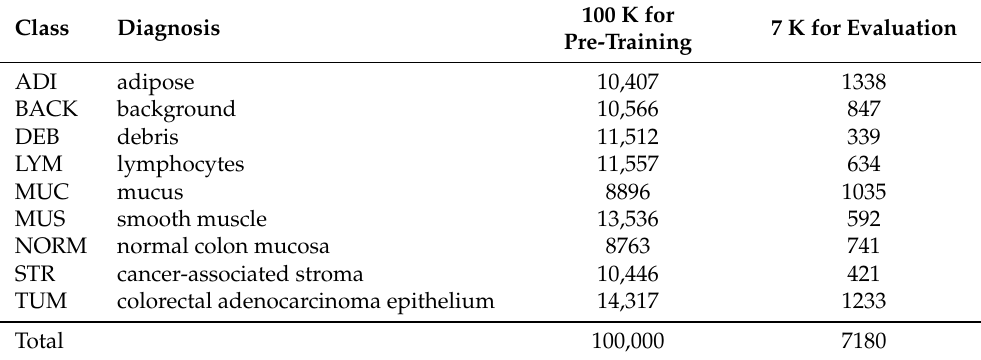
Table 1. The organization of the NCTCRC dataset